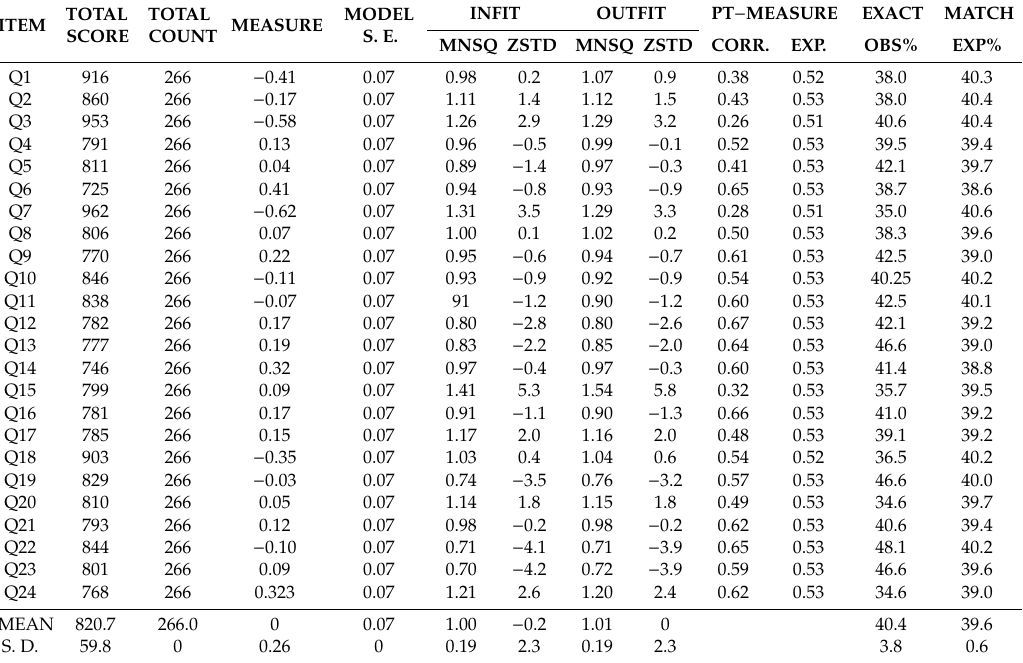
Table 7. Item goodness-of-fit and item di ffi